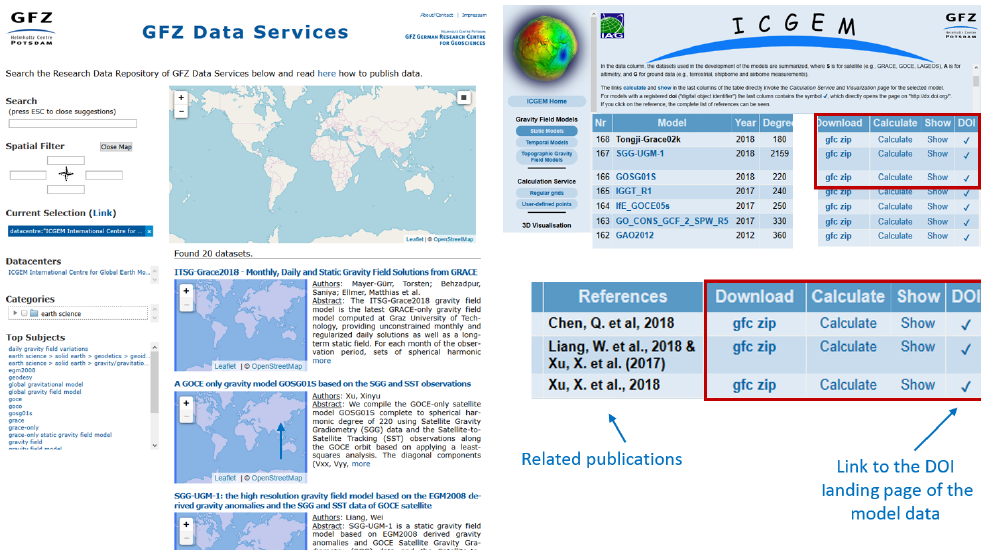
Figure 19. Illustration of the two different possibilities to access the DOI-referenced ICGEM models: via the catalogue of GFZ Data Services (left) and the ICGEM website (right). GFZ Data Services have created a specific data centre for the ICGEM service (http://dataservices. gfz-potsdam.de/portal/?fq=datacentrefacet:-DOIDB.ICGEM-ICGEMInternationalCentreforGlobalEarthModels, last access: 6 May 2019). On the ICGEM website (to the right, table of models), each ICGEM model with assigned DOI is linked to the DOI landing page via the mark in the DOI